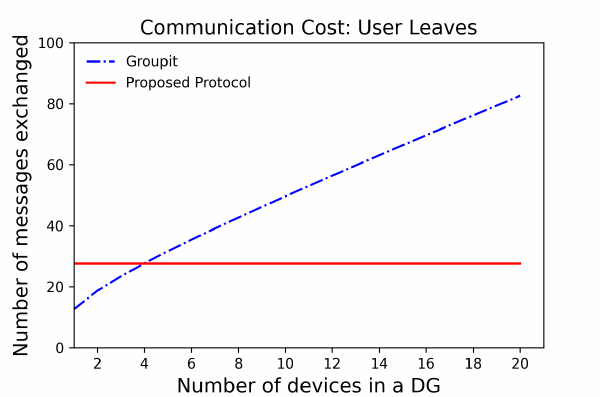
Figure 12. The figure shows the communication costs under GroupIt and the proposed protocol versus the number of devices in a DG for the case when a user leaves group SG x . Again, as shown in Fig. 11, our proposed protocol has lower communication cost than GroupIt.